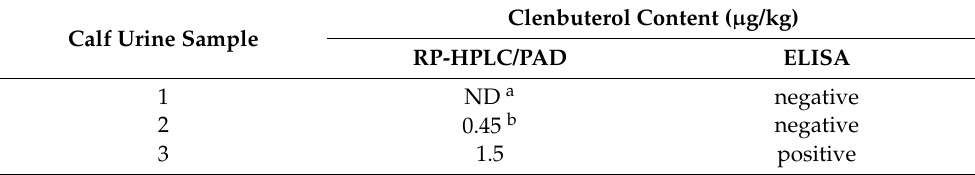
Table 5. Clenbuterol determination in calf urine samples by RP-LC-PAD and